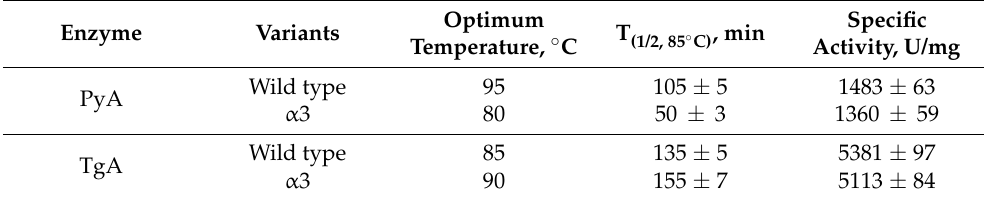
Table 3. α 3 affects thermostability of thermo-ASNases